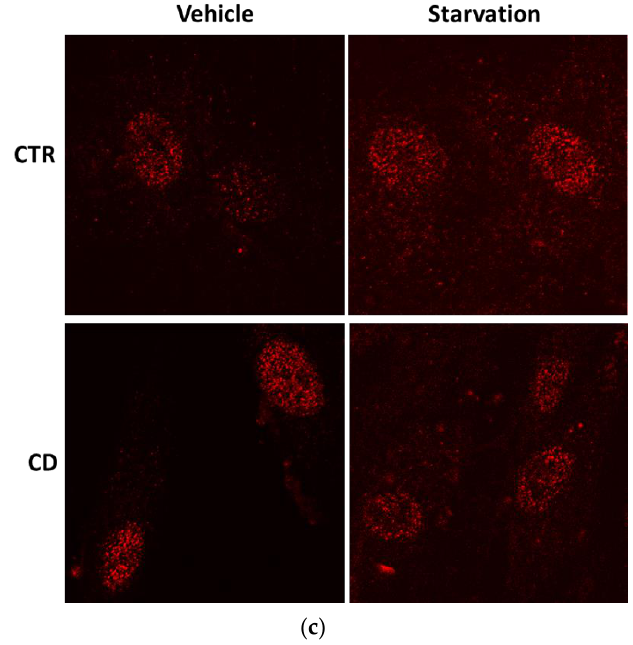
Figure 9. LC3 levels in the presence of starvation medium and/or of bafilomycin A1. ( a ) Representative Western blot anti-LC3 on samples from one control and one celiac culture, treated with bafilomycin A1 1 µM for 4 h; where indicated, cells were previously starved for 2 h. ( b ) Densitometric analyses of LC3-II isoform levels relative to samples from three controls and three celiac cultures treated as in ( a ). Protein levels are normalized with respect to GAPDH expression and reported as variations with respect to the relative vehicle-treated sample. Data are reported as mean ± SE. * p < 0.05 vs. the respective vehicle. ( c ) Confocal immunofluorescence images of fibroblasts from control and celiac subjects stained with anti-LC3 antibodies (magnification 63×).